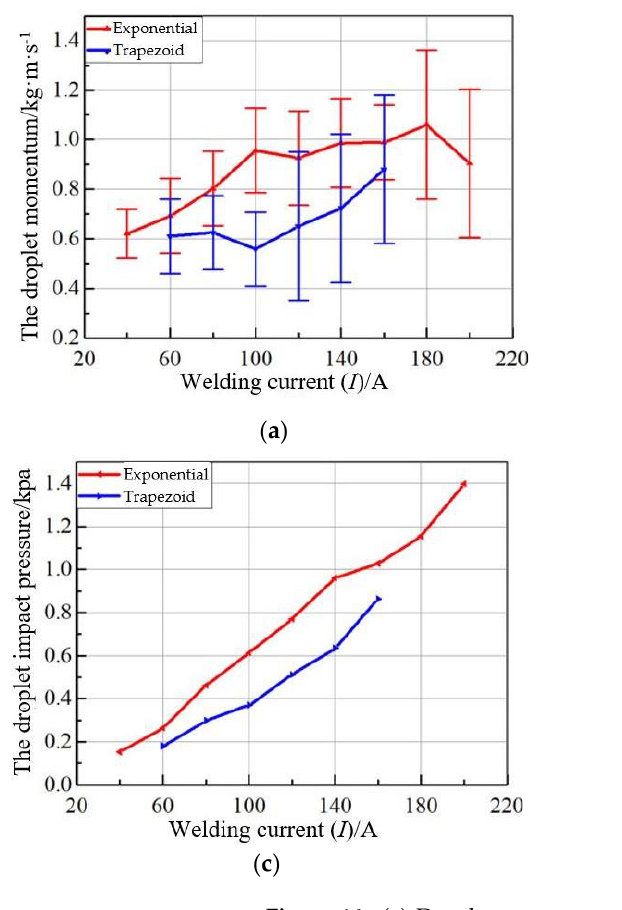
( b ) Figure 15. ( a ) The droplet and arc size at different times during a single pulse period (trapezoid pulse waveform, I = 100 A); ( b ) transient arc pressure and heat input power (trapezoid pulse wave- form, I = 100 A). Figure 16 shows the variation trend of droplet momentum, equal impact force, and arc pressure of trapezoidal pulse and exponential pulse under different welding current conditions. According to Figure 16a – c, it can be found that the momentum and the droplet impact equivalent pressure of trapezoidal pulse are higher than those of exponential pulse under all current welding parameters. As shown in Figures 16a and 3a, with the increase